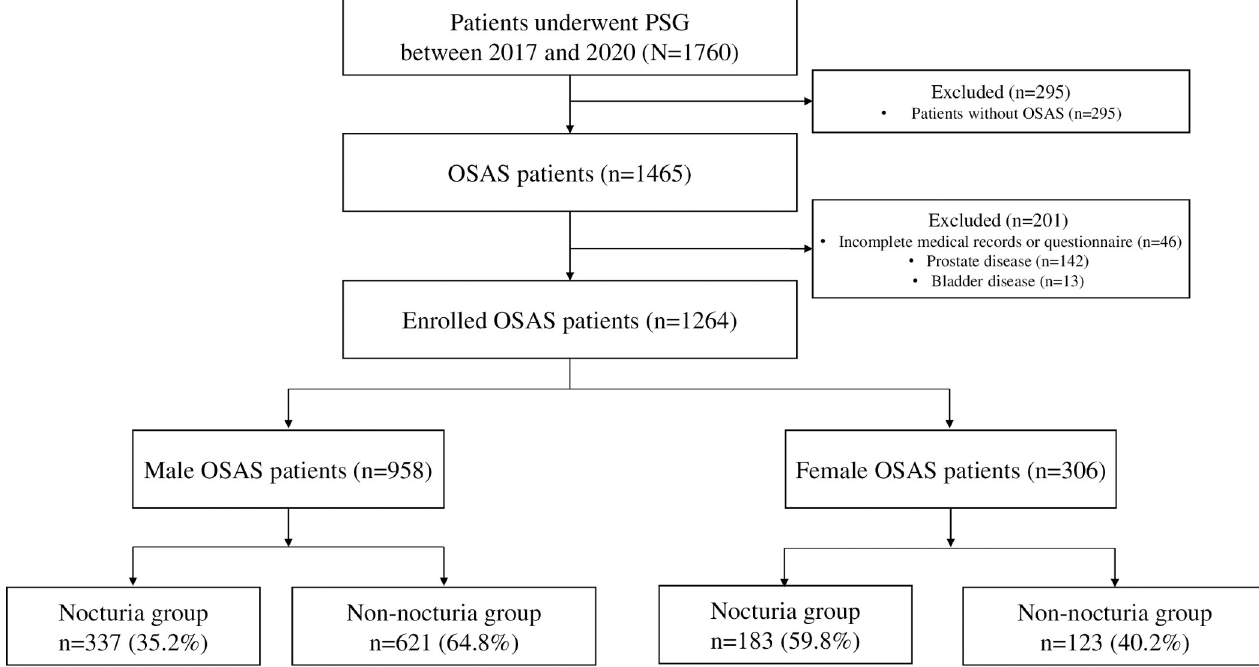
Fig 1. Study flow chart. We screened 1,465 patients with OSAS (Apnea-Hypopnea Index � 5/h on PSG) out of 1760 patients who underwent PSG. Patients who had incomplete medical records or questionnaires, prostate disease, or bladder disease were excluded. We registered 1,264 participants, and they were divided into male and female groups and then subdivided into the nocturia and non-nocturia groups according to the following question, “Do you go to the bathroom two times or more during your sleep?”. OSAS: obstructive sleep apnea syndrome. PSG: polysomnography.